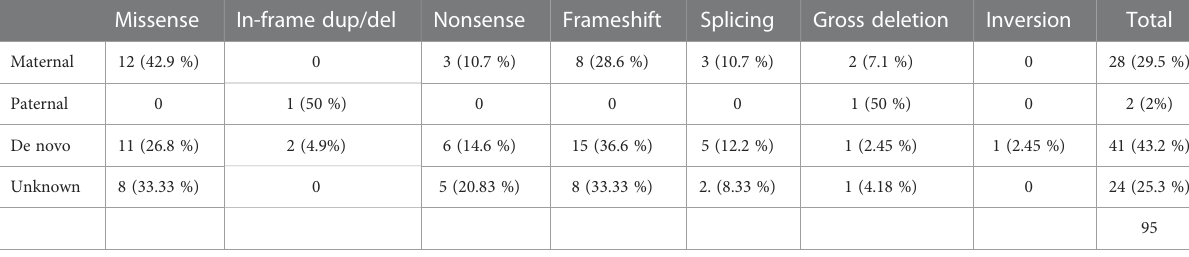
TABLE 1 Types of variants identi fi ed in the GNAS gene and their inheritance.